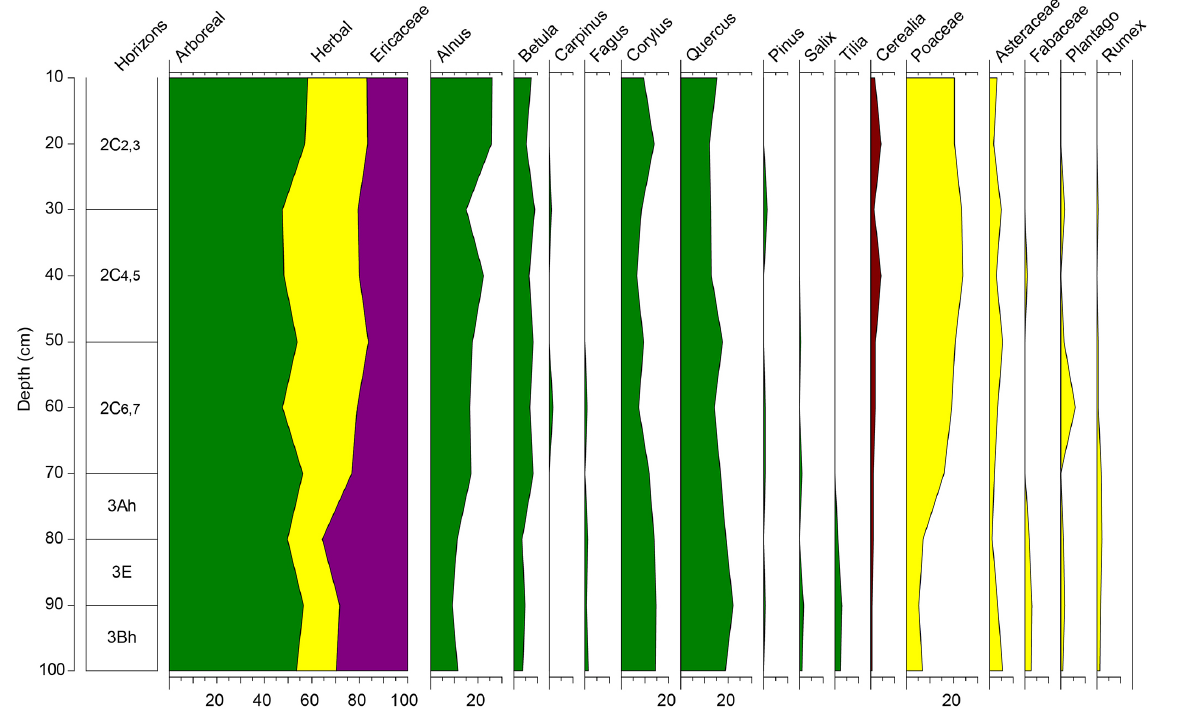
Figure 14. Pollen diagram of the Bedafse